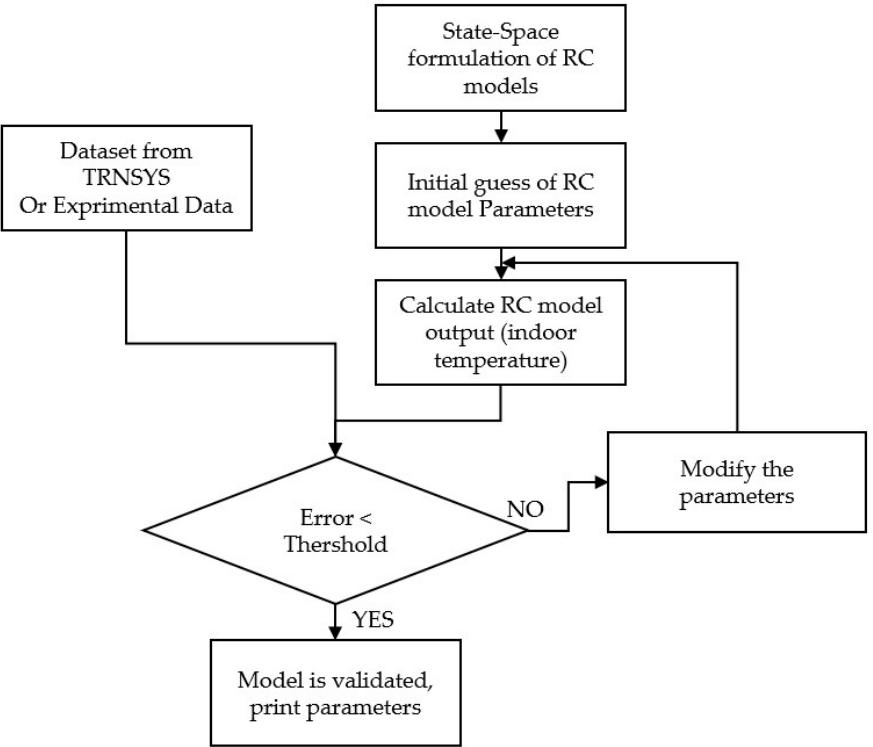
Figure 8. A scheme of implementation of the system identification technique for the parameter es ‐ timation of RC models based on the available datasets from TRNSYS simulations and experiment.